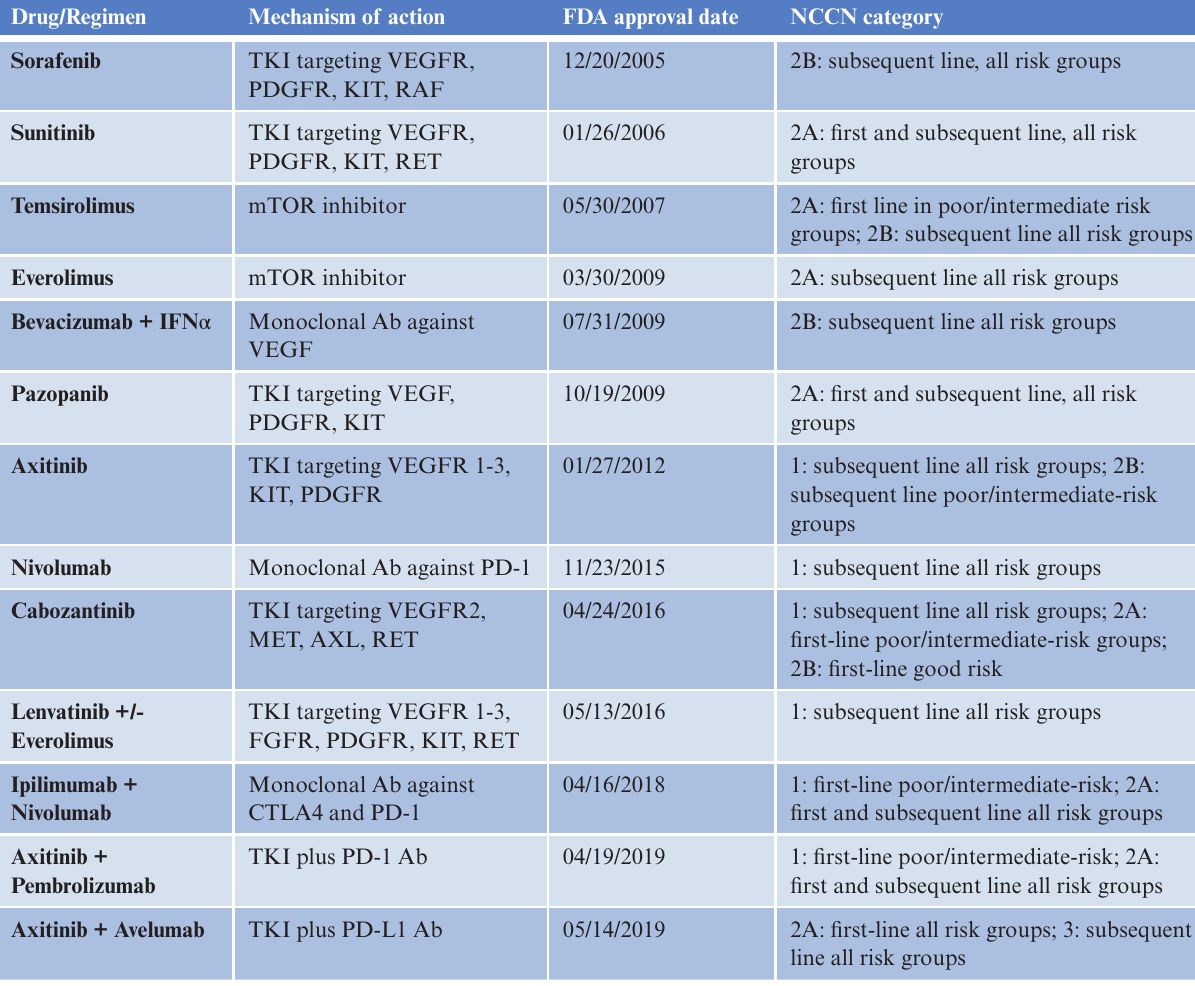
Table 1: Approved drugs and regimens for patients with advanced RCC.